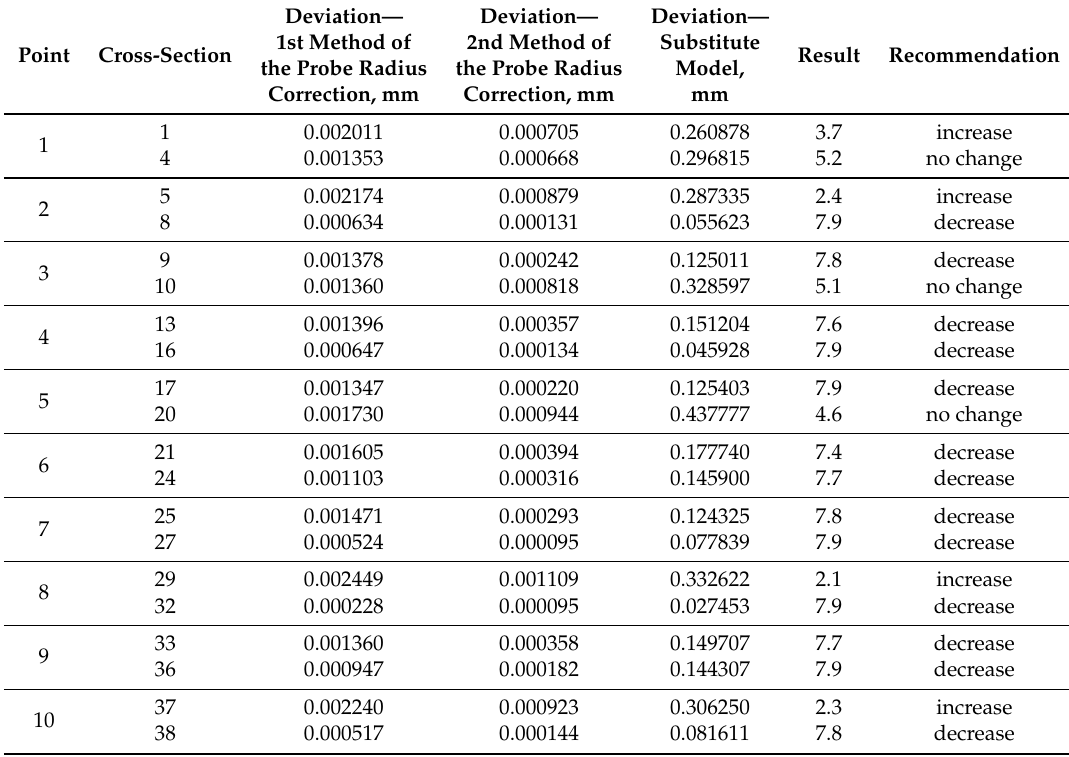
Table 5. The results of the second part of the simulation investigations and the recommendations regarding the number of measurement points located along the selected measured cross-sections for the first free-form